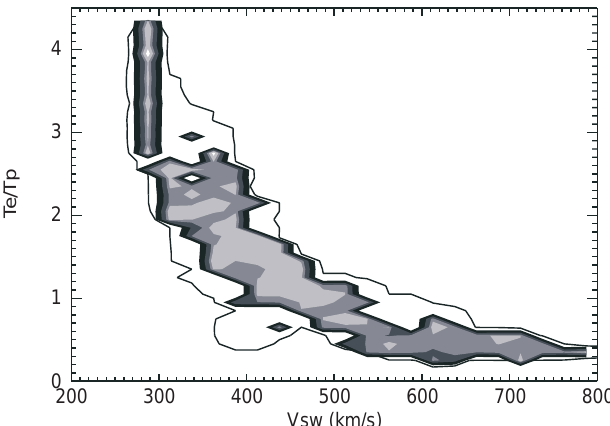
Fig. 9 The thin line delimits the region of the plane [ V sw ; T e = T p ] sampled by the TDS. The grey contours give the energy density (cid:22) E 2 of the 17 ms TDS events, calculated with Eq. 3. The five grey levels correspond to the values (cid:255) 12 ; (cid:255) 10 : 5 ; (cid:255) 9 : 35 ; (cid:255) 8 : 75 and (cid:255) 7 : 75 for (cid:22) E 2 , in V 2 /m 2 log 10